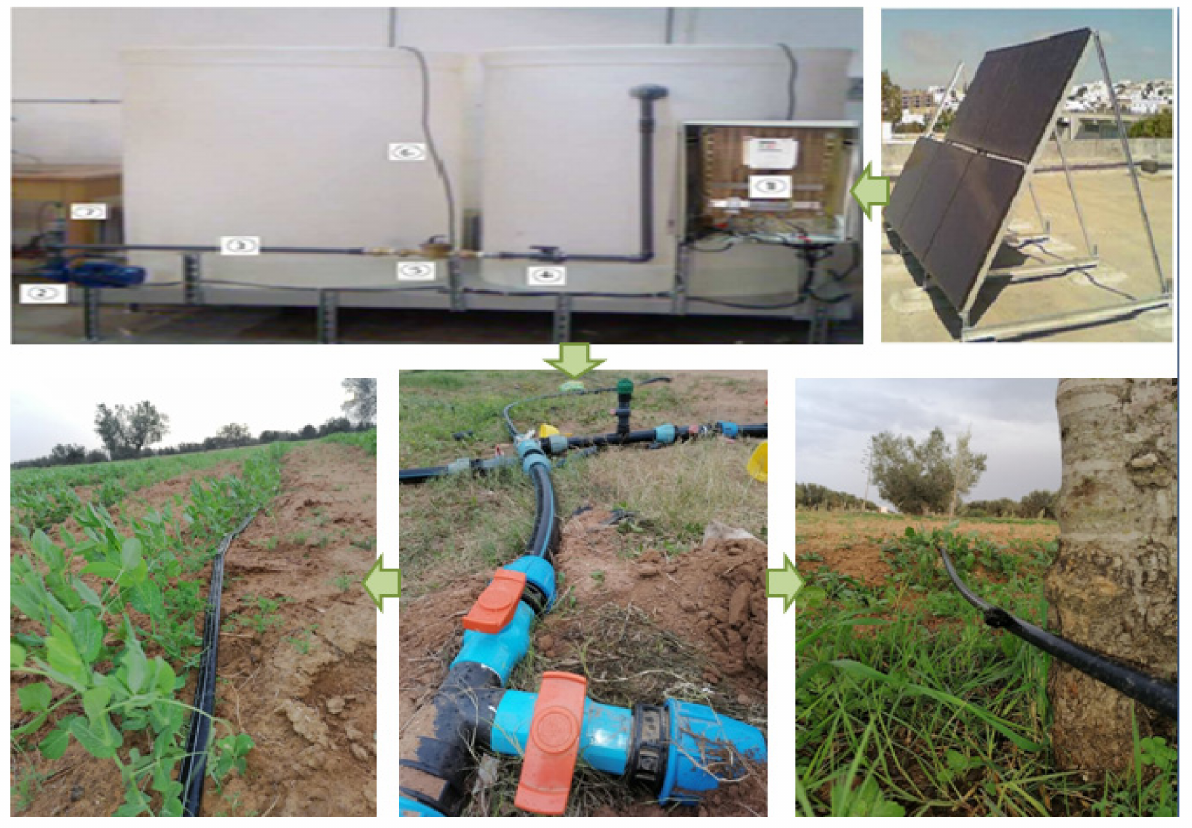
Figure 11. Irrigation system proposed.